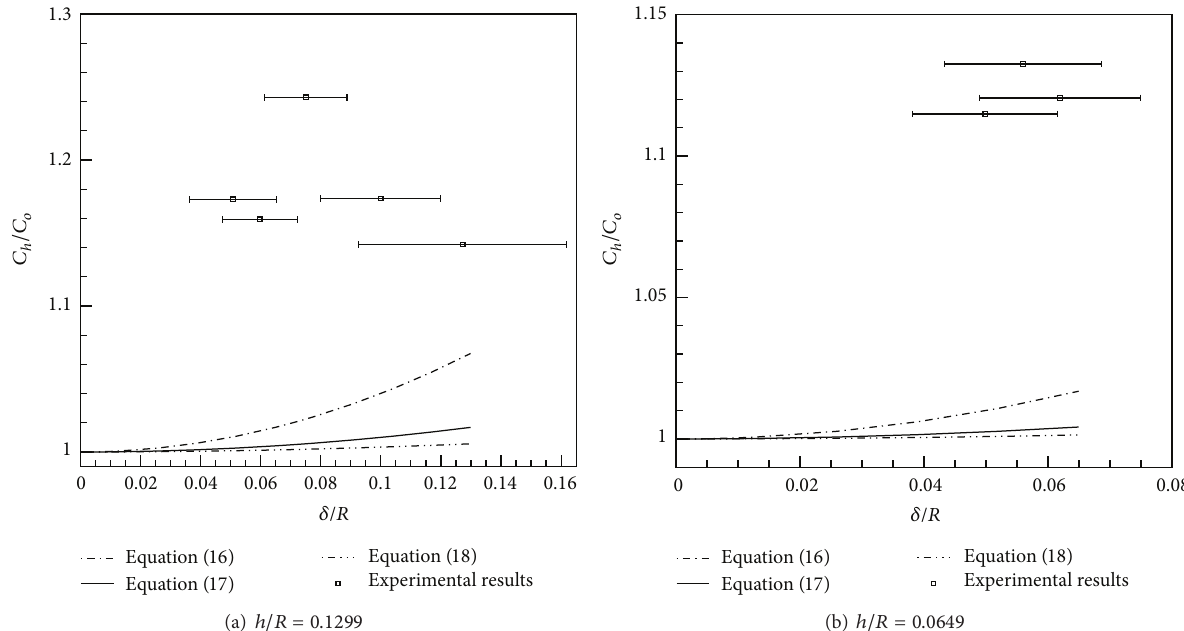
Figure4:Comparisonofthedimensionlessexperimentalresultsand(16)–(18)regardinghydrauliccapacitanceinthelinearregion:(a)plotted as ℎ/𝑅 = 0.1299 ; (b) plotted as ℎ/𝑅 = 0.0649 .